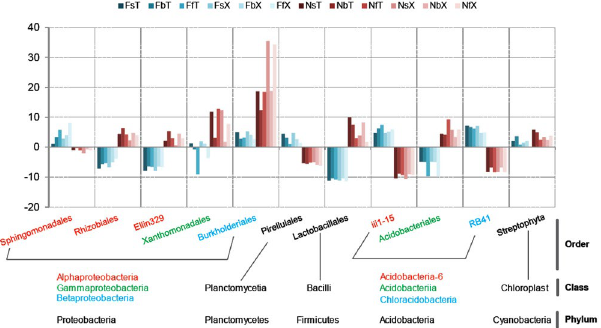
Figure 3. Analysis of increased and reductions of the abundance of major bacteria in two types of soils at different developmental